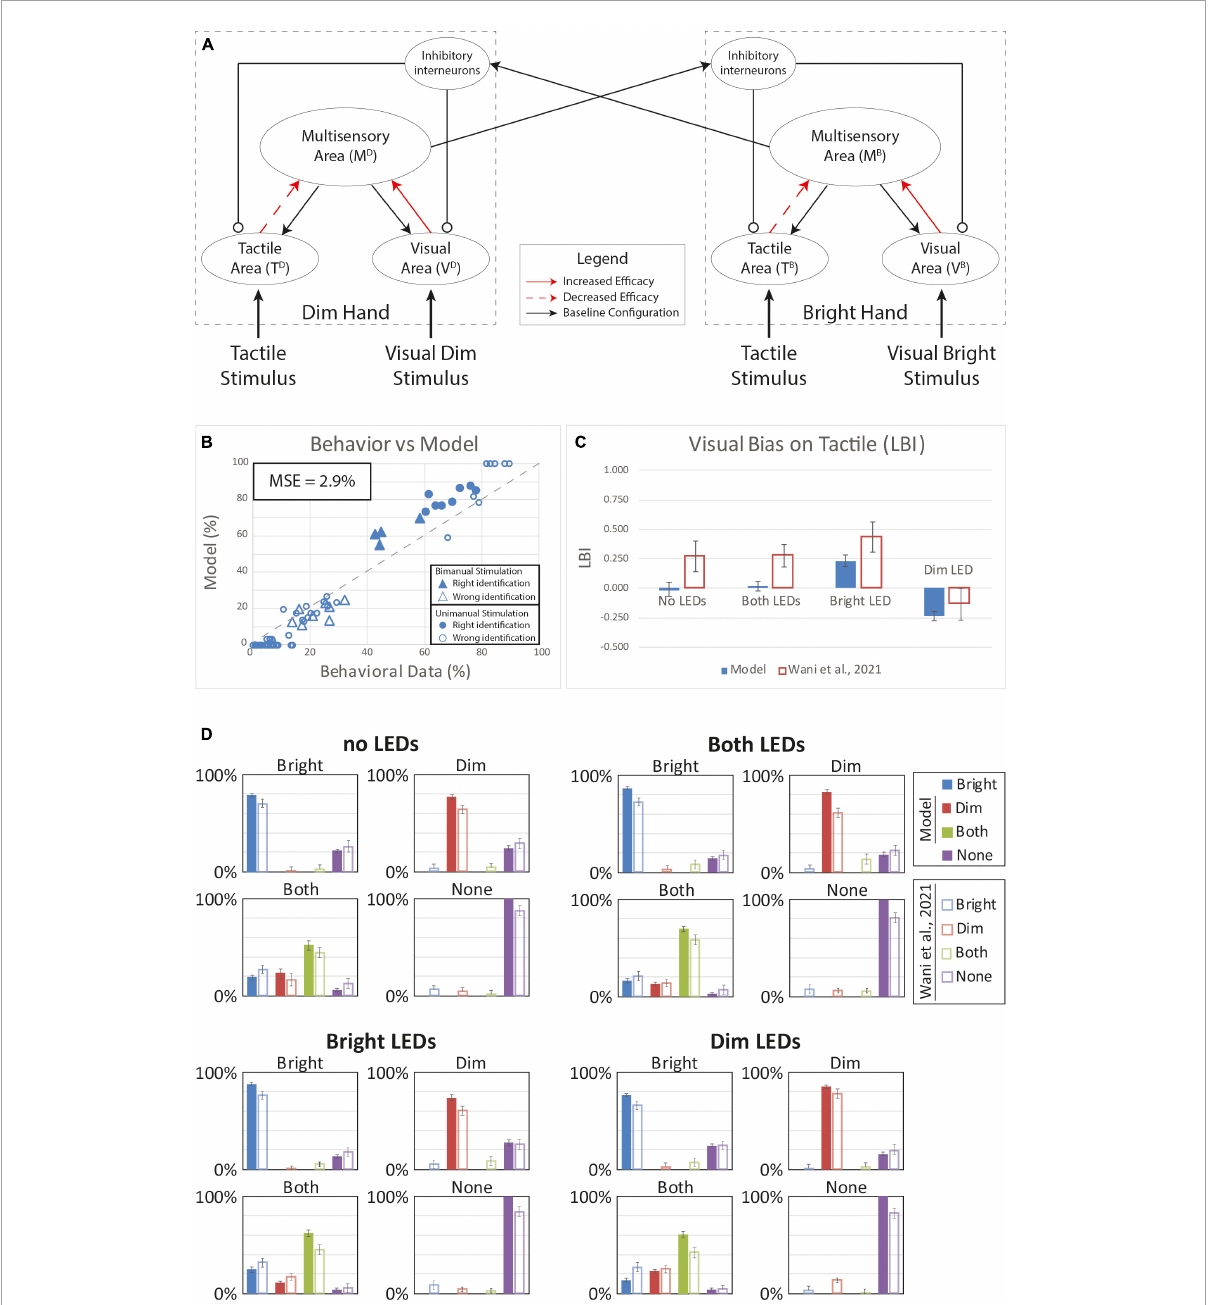
FIGURE5 Tactile perception with a reorganization of the synaptic representation of the two hands. Visual connectivity was increased by 20% and the tactile efficacy was lowered of the same quantity. Overall, the sum of the synaptic efficacy targeting the multisensory area and coming from the modality specific input regions was kept constant. (A) Model’s structure with the altered pattern of connectivity. Red solid arrows identified synapses with increased efficacy, red dashed arrows the synapses with lower efficacy. Panel (B) depict the comparison between model’s responses and experimental data, in case of the different tactile and visual stimulations. In the diagram the triangles represent the tactile responses in case of bimanual tactile stimulations, irrespective of the visual stimuli. Full triangles refer to the correct identification of bimanual stimulations; empty triangles report the percentages of different sensory perceptions. Circles report the responses to unimanual tactile stimulations, regardless of the positions of the visual stimuli. Full circles represent the correct responses, empty circles report the other responses. Panel (C) reports the LBI for the different visual configurations. (D) In each box we reported the percent tactile responses ( y -axis), distributed across the four possible choices (Bright, Dim, Both, None, on the x -axis), mediated over the 20 simulated subjects, to a specific tactile input (T) configuration, specified in each box title: T on the bright hand, “Bright,” on the dim hand, “Dim,” on both hands simultaneously, “Both,” and no stimulus, “None”; and for each visual input stimulation: no LEDs, both LEDs, Bright LED, Dim LED. Errorbars indicate s.e.m. The responses obtained by the model, are compared to the empirical results of Wani et al.